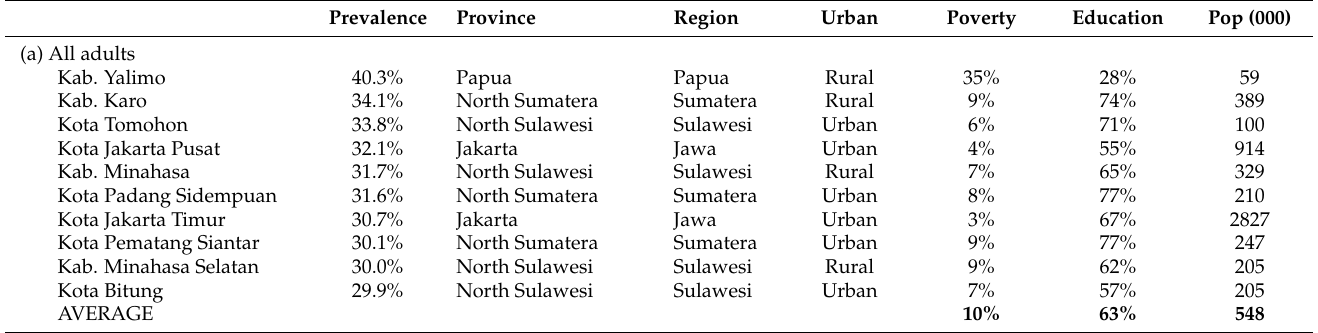
Table 4. Ten districts with HIGHEST prevalence of obesity among adults in Indonesia,